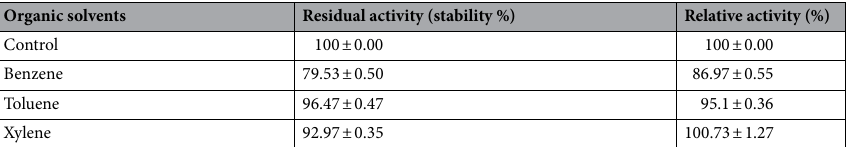
Table 4. Effect of organic solvents on the activity and stability of purified cold-active Apr-BO1. The values are the mean of three replicates ± standard deviation.